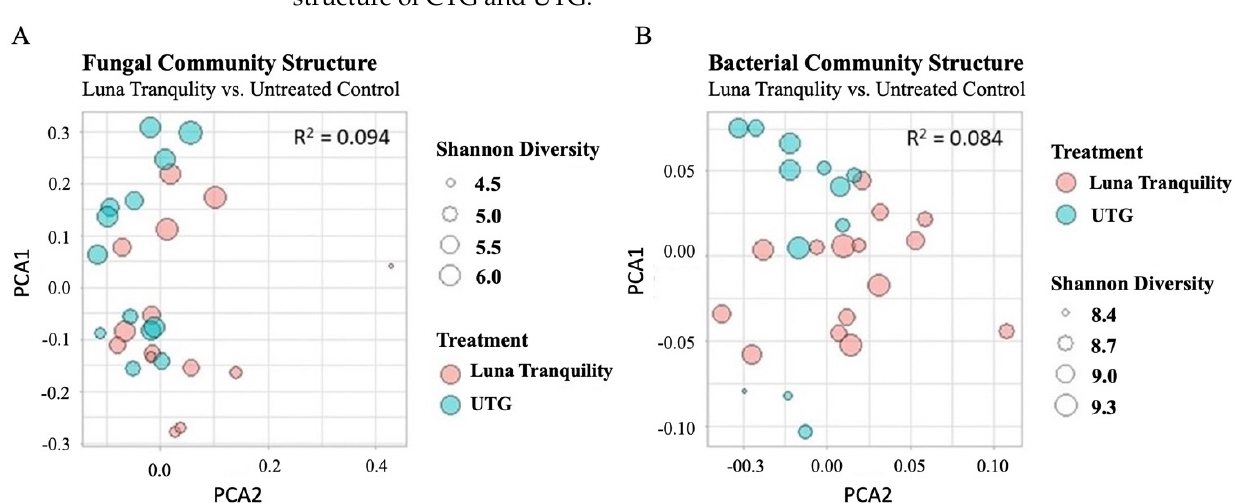
6 of 12 Figure 1. Alpha diversity metrics for CTG and UTG. ( A ): Bacterial community. ( B ): Fungal commu- nity. For each metric, columns marked by differing letters are significantly different (Wilcoxon test, BH-adjusted p < 0.05). 3.4. Beta Diversity ADONIS tests comparing the significance of difference between UniFrac matrices for each treatment group found that 10% of variance in the 16S rRNA dataset could be at- tributed to the effect of individual treatments ( p < 0.05). Notably, Luna Tranquility was the only treatment group responsible for significant variance from UTG, causing 9% of the overall variance between the two groups (Figure 2). With the fungal ITS2 dataset, Luna Tranquility was also the only treatment group which differed significantly different from